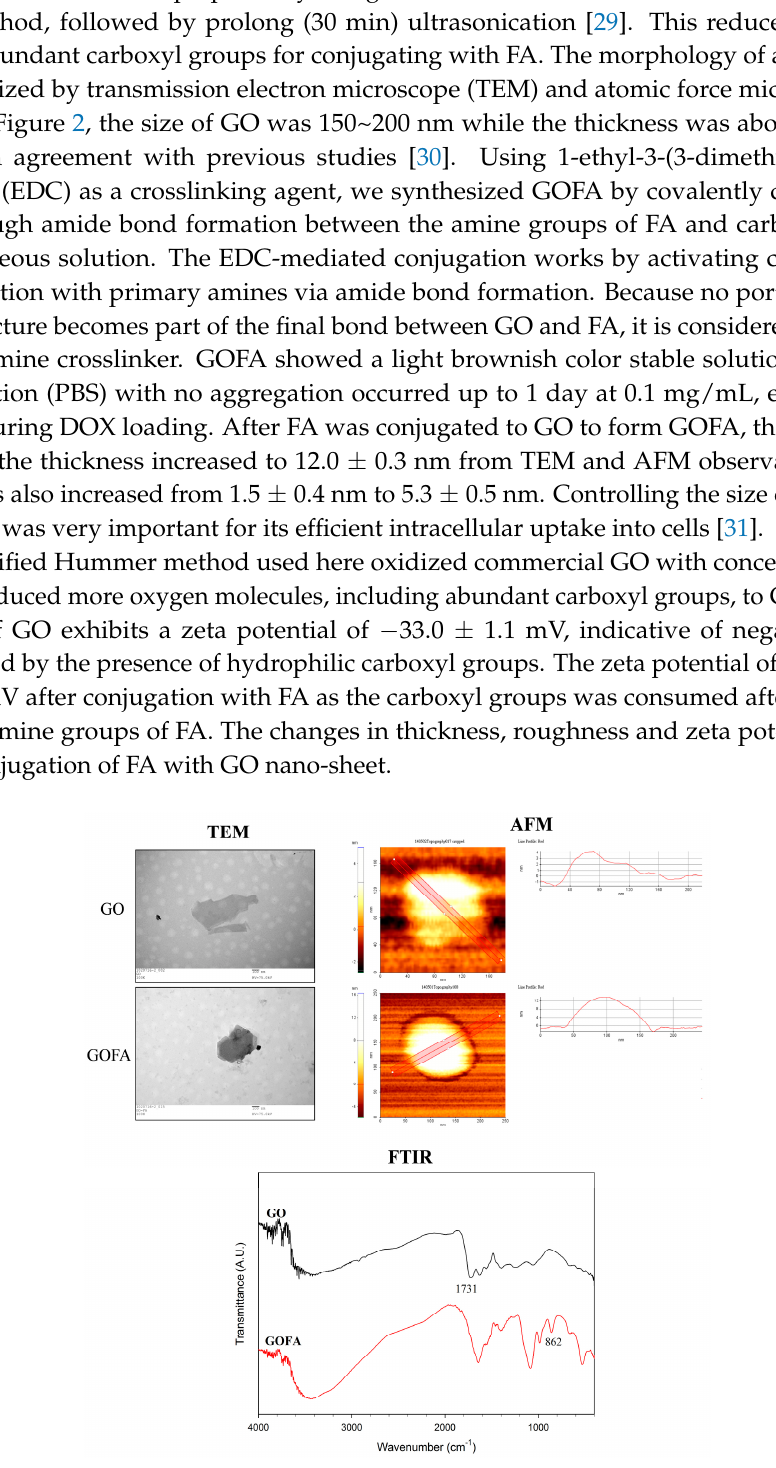
Figure 2. Transmission electron microscopic (TEM), atomic force microscopic (AFM) and Fourier transform infrared (FTIR) spectroscopic analysis of GO and GOFA.